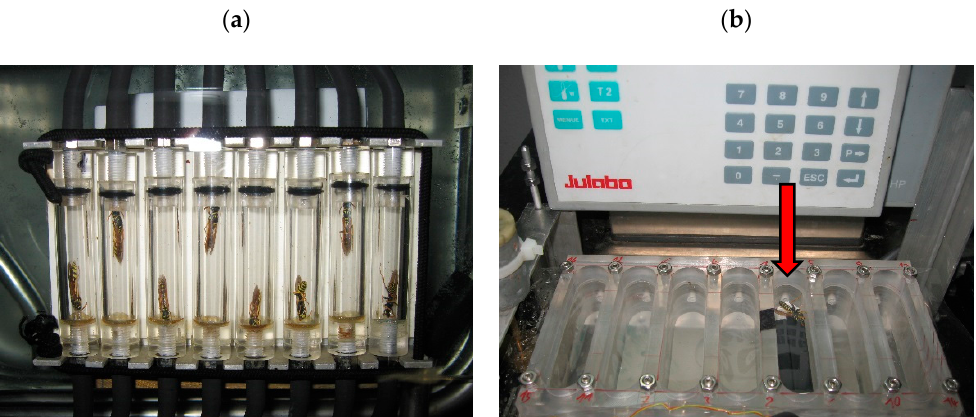
Figure 1. ( a ) Eight measurement chambers to measure the CO 2 production rate of active and resting wasps ( Polistes biglumis ). ( b ) Seven measurement chambers in the water bath to measure the endothermic activity and CO 2 production rate of active and resting wasps ( Polistes biglumis ). The arrow indicates the stocked measurement chamber.